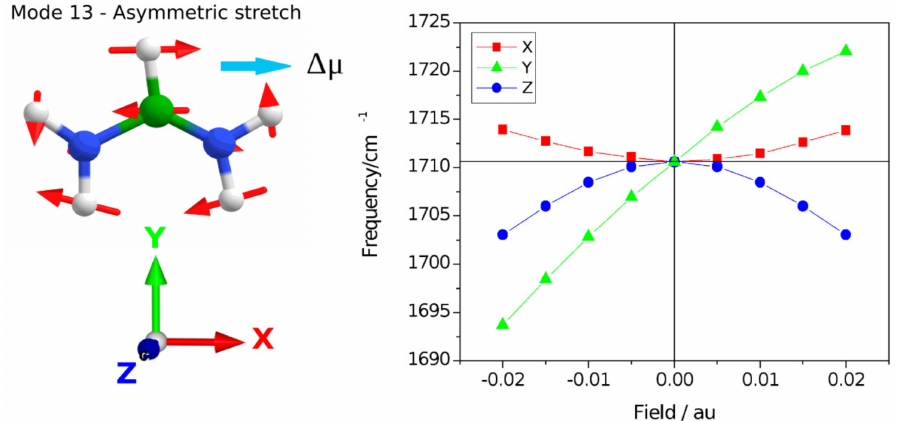
Figure 5. Calculation of the vibrational Stark effect on the asymmetric stretching mode at the b3lyp/6- 311+g(d,p) level. The transition dipole moment for mode 13, ∆ µ , is indicated corresponding to the direction of the N-N vector. The harmonic frequencies following geometry re-optimization are scaled by 0.967 and shown for application of fields in the X, Y, and Z directions